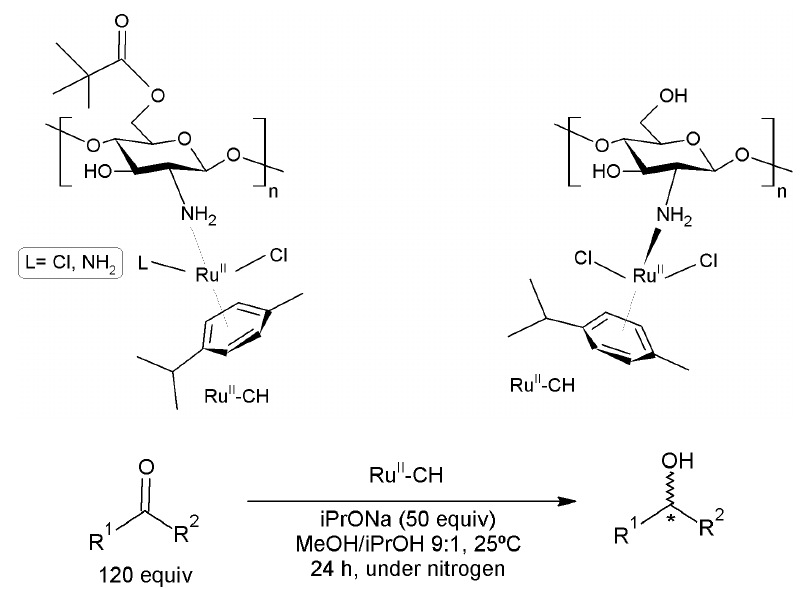
Figure 26. Chitosan-based catalysts loaded with Ru used in transfer hydrogenation reactions.